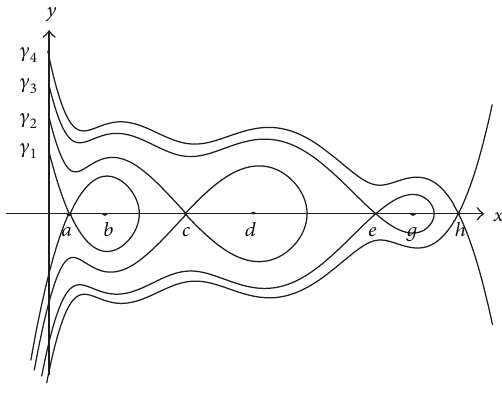
Figure 1: The phase portrait of